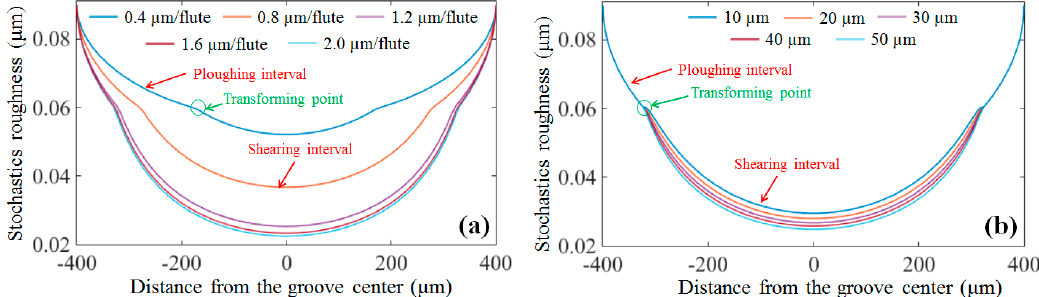
Figure 7. Stochastic roughness with different ( a ) feed rates and ( b ) cutting depths.